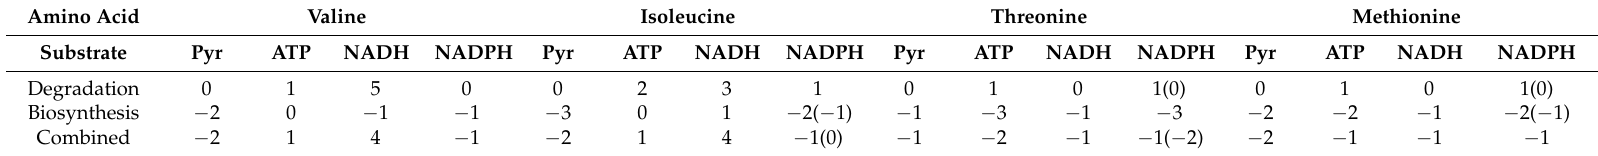
Table 7. Theoretical molar yields 1 for propionic acid production using via amino acids synthesis and degradation.